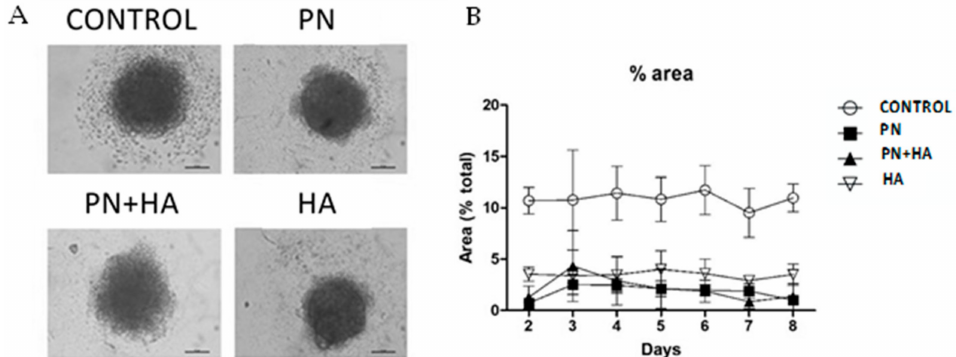
Figure 3. A thick cloud of particles appeared around the spheroid soon after seeding. ( A ) Micropho- tographs of spheroids after eight days of culture under different conditions. Magnification 10 × ( B ) Quantification of debris area in the different cultural groups over time. The debris area in control groups is significantly higher than all other groups at all time points.